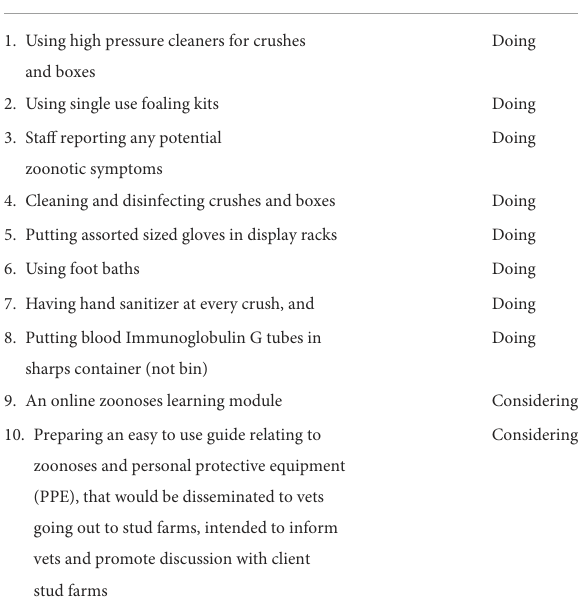
TABLE 4 Ten other strategies related to personal protective equipment (PPE) that were described by participants in the self-audit survey, under the optional survey question for “something else”, showing status as “doing,” or